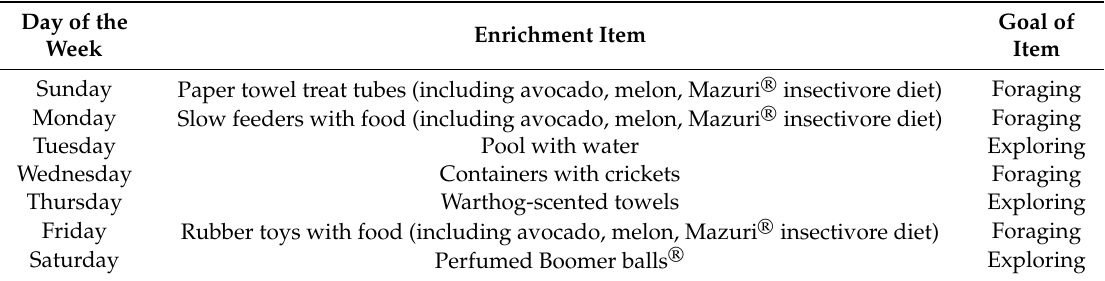
Table 2. List of enrichment items given each day of the week and the goal of those